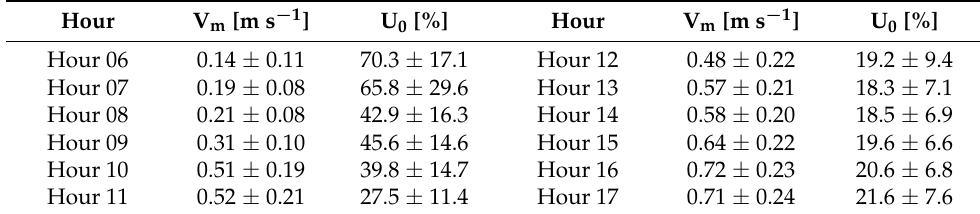
Figure 6. Simulated airflow patterns (m s − 1 ) for each scenario evaluated. Table 4. Numerical parameters obtained for air flow